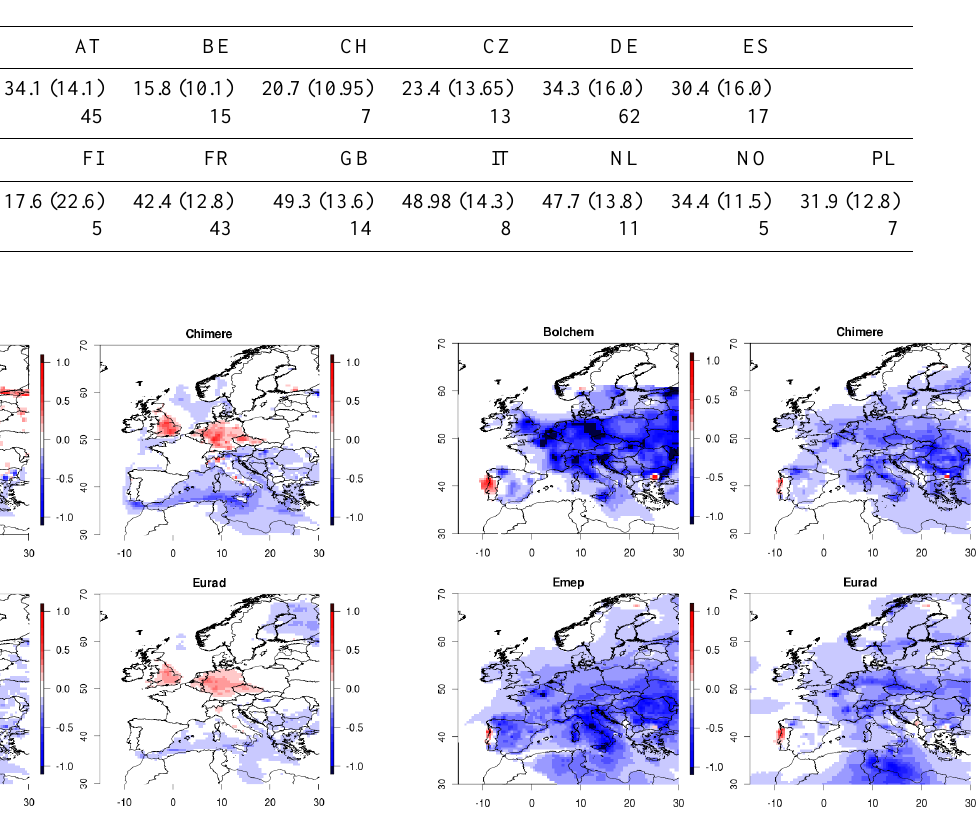
Figure 15 : Same as Figure 14 for O 3 . Fig. 15. Same as Fig. 14 for O 3 .